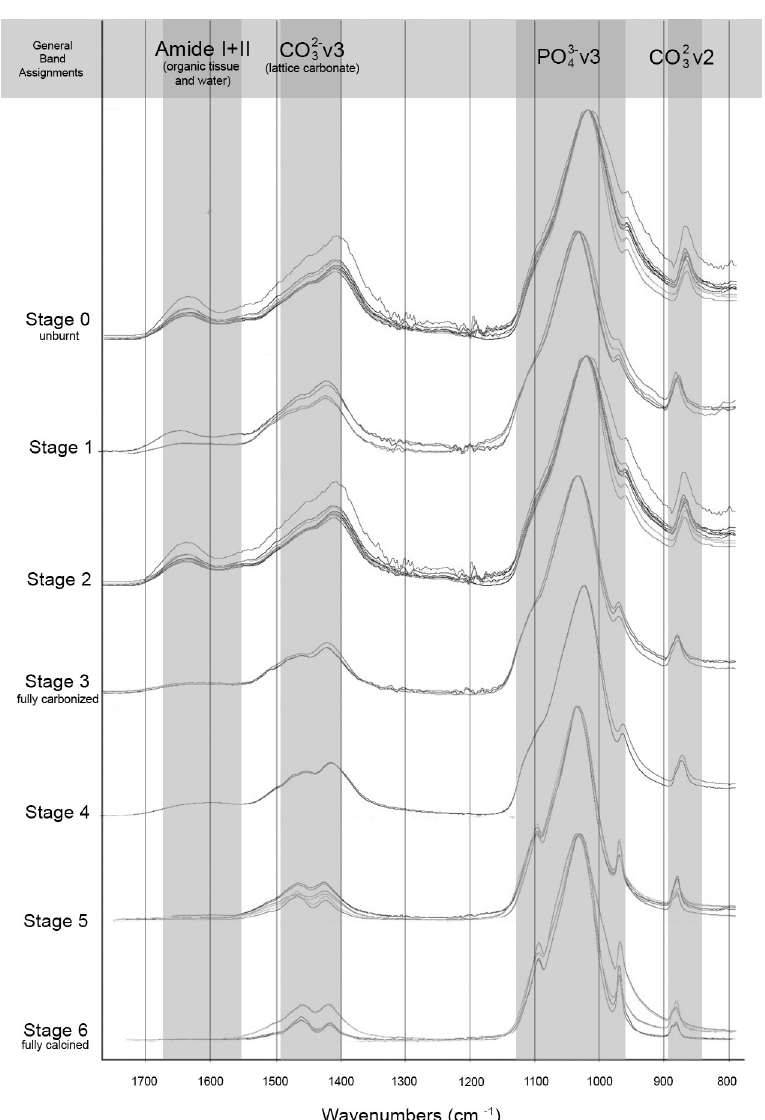
Fig 5. FTIR-ATR spectra of archaeological fauna from T-17 grouped by stage of burning intensity following Stiner et al. [27] with functional groups highlighted in the range of 1700–800 cm -1 .